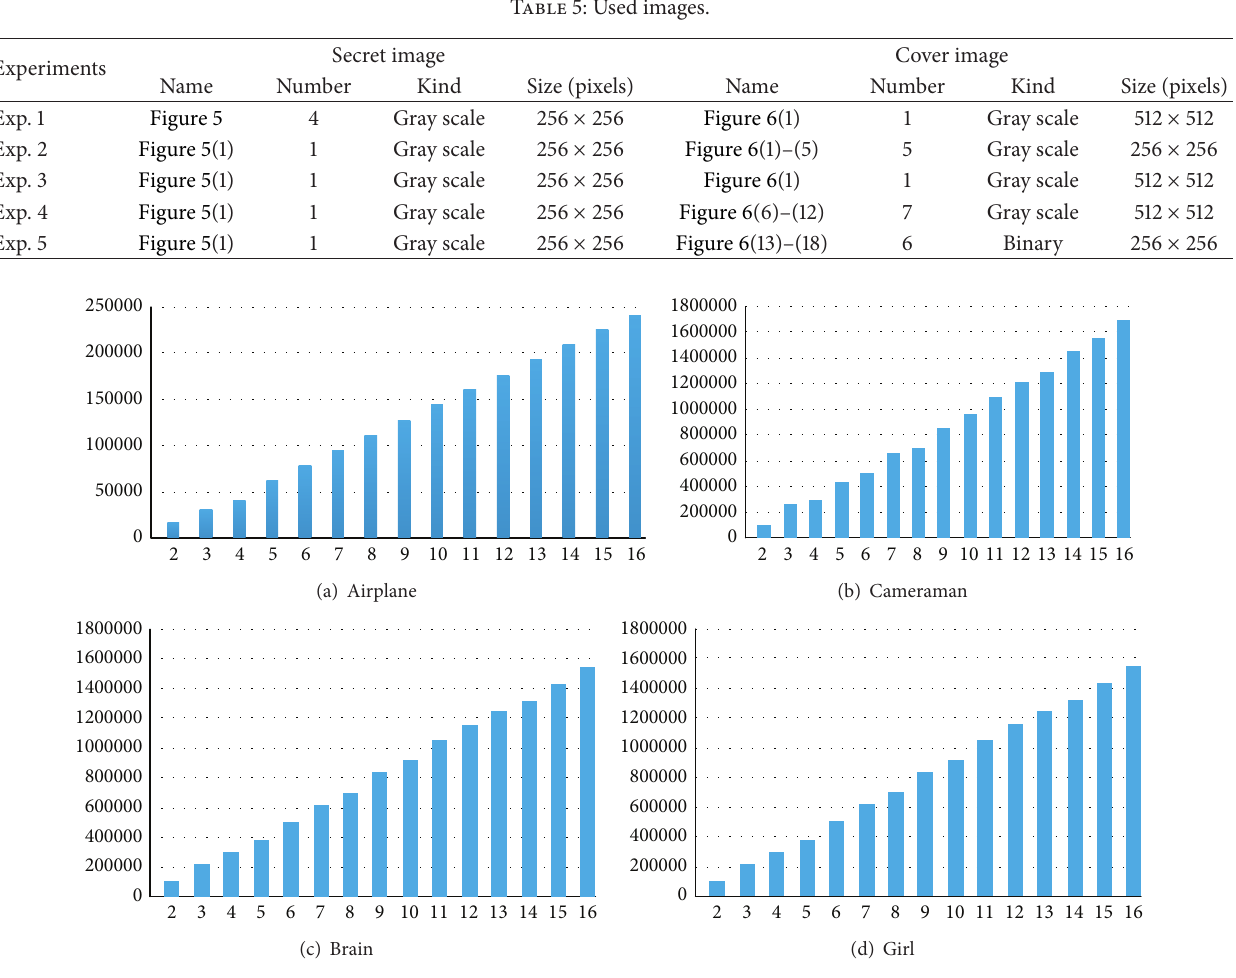
Figure 8: The embedding capacity EC with determined secret image.